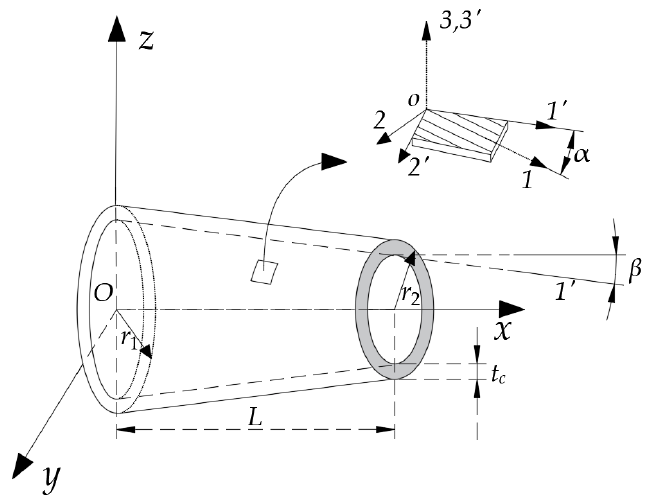
Figure 1. Illustration of the simplified boring bar model.